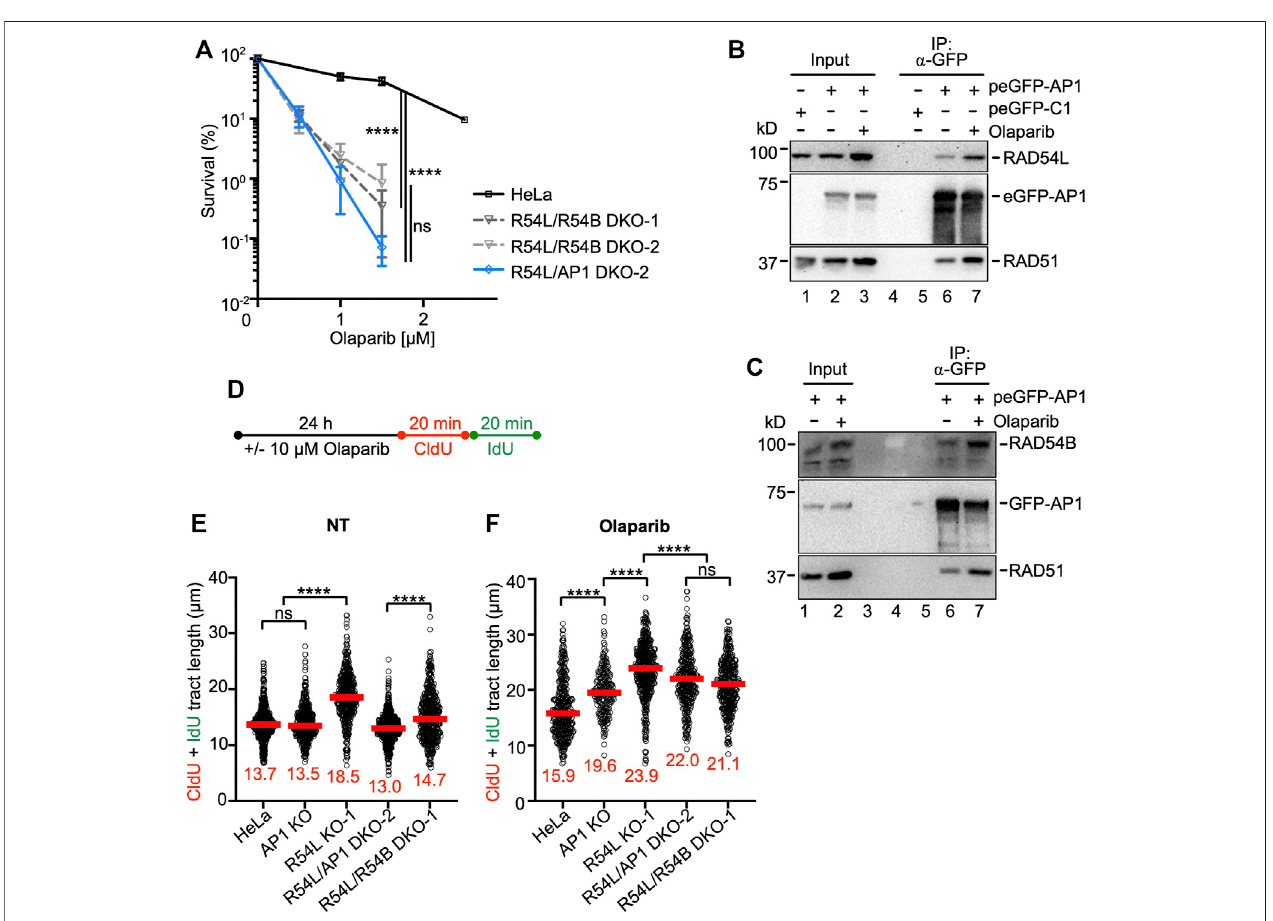
FIGURE 5 | Loss of RAD54L and RAD51AP1 or of RAD54L and RAD54B enhances cellular sensitivity to olaparib to similar extent. (A) Results from olaparib clonogenic cell survival assays of HeLa, R54L/R54B DKO-1 and DKO-2, and R54L/AP1 DKO-2 cells. Data points are the means from two independent experiments ±SD. ****, p < 0.0001; ns, non-signi fi cant; two-way ANOVA followed by Tukey ’ s multiple comparisons test. (B) Western blots to show that endogenous RAD54L co- precipitates inanti-eGFPprotein complexesof AP1KO cells ectopically expressing eGFP-RAD51AP1 (here: peGFP-AP1) in the absence (lane 6) and after a1-day incubation in 10 μ M olaparib (lane 7). RAD51: positive control for interaction, aspreviously shown in different cell types (Kovalenko et al., 1997; Wieseet al., 2007). Lane 5: negative control (cells transfected with peGFP-C1 vector). (C) Western blots to show that endogenous RAD54B co-precipitates in anti-eGFP protein complexes of R54L/AP1 DKO cells ectopically expressing eGFP-RAD51AP1 (here: peGFP-AP1) in the absence (lane 6) and after a 1-day incubation in 10 μ M olaparib (lane 7). (D) Schematic ofthe experimental protocol fortheDNA fi ber assay inunperturbed cellsand after olaparib. (E,F) Median tractlength(CldU +IdU)ofDNA fi bers in HeLa,AP1 KO, R54L KO-1, R54L/AP1 DKO-2 and R54L/R54B DKO-1 without (NT) and with olaparib treatment. Data points are from 130 to 230 fi bers of three independent experiments each, with medians in red. ****, p < 0.0001; ns, non-signi fi cant; Kruskal-Wallis test followed by Dunn ’ s multiple comparisons test.